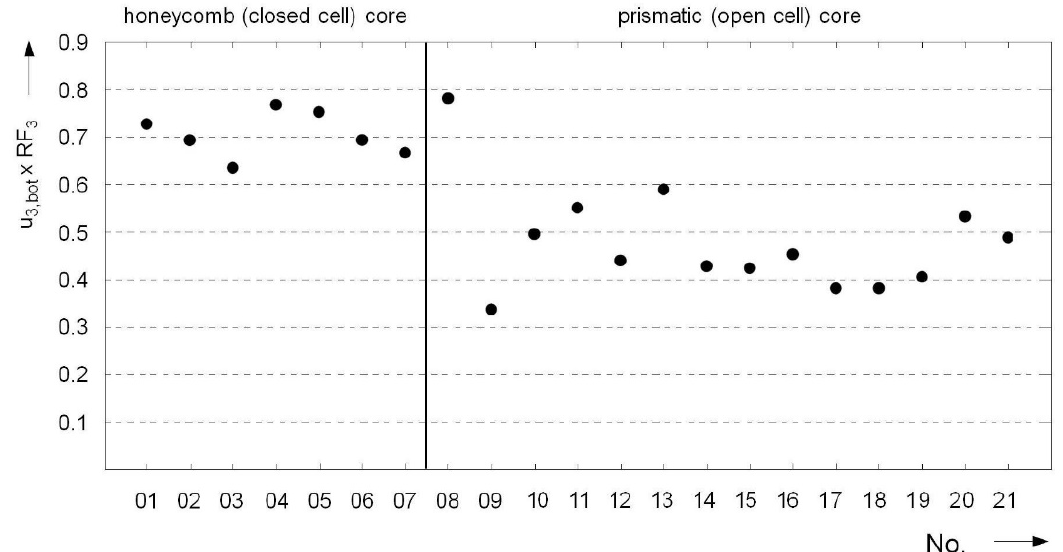
Figure 28. Performance indicator for honeycomb (closed-cell) cores and prismatic (open-cell) cores.